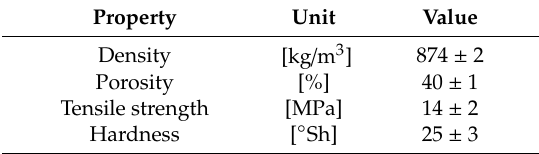
Table 5. Specifications of the pipe fittings for the active filling.